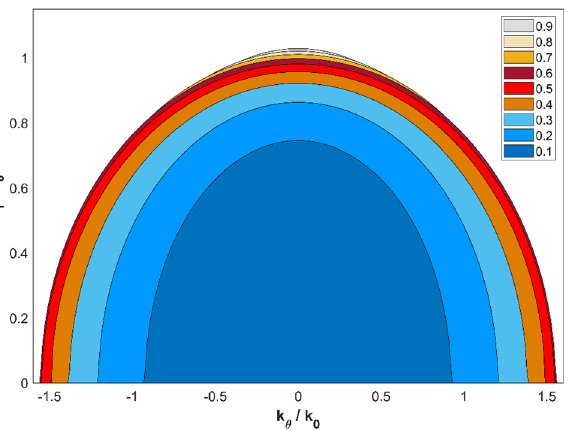
Figure 6. Dispersion curves of the cylindrical hyperlens composed of water and stainless steel fins with various filling